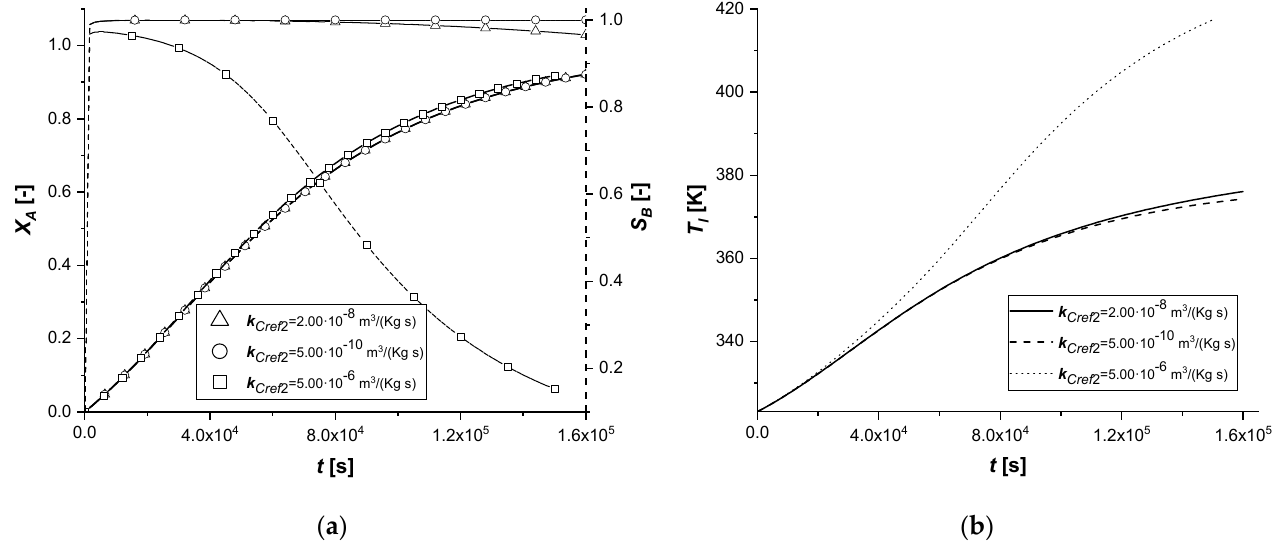
Figure 16. EY k Cref 2 investigation. ( a ) Bulk profiles over time of X A and S B . ( b ) Bulk profile of T l over time.